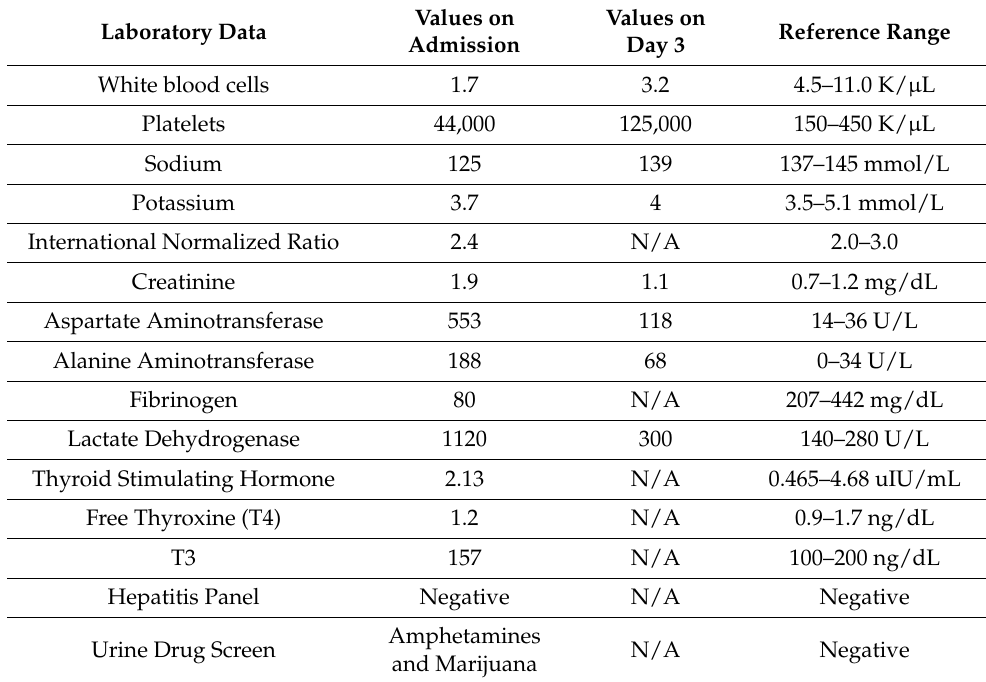
Table 1. Showing Laboratory data on admission and on hospitalization day 3 with references